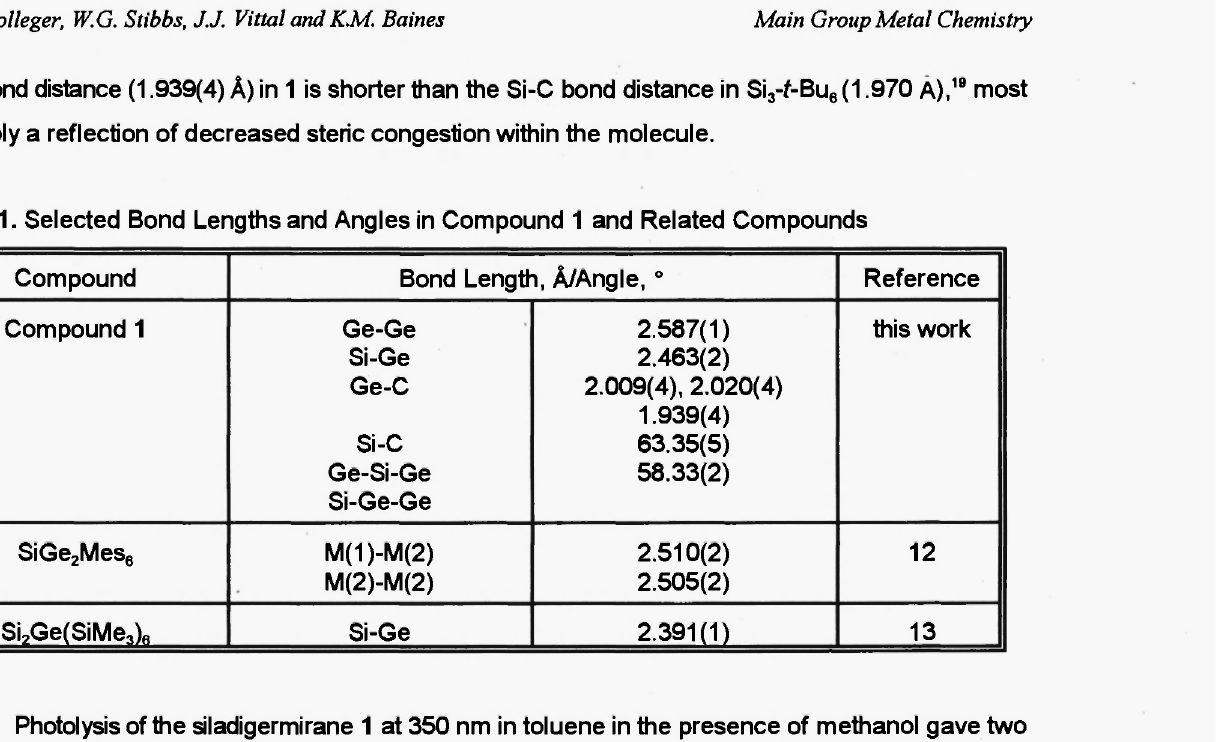
Table 1. Selected Bond Lengths and Angles in Compound 1 and Related